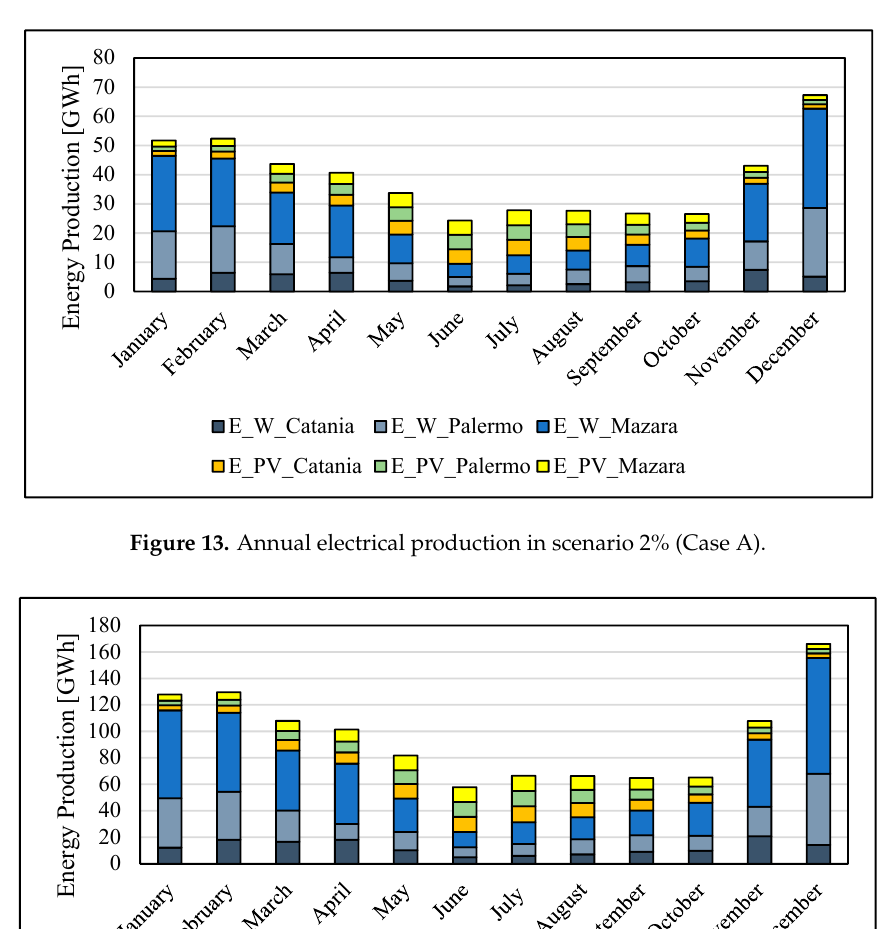
kW Table 4. Monthly solar radiation in the three sites: Catania, Palermo, and Mazara del Vallo [51]. (kWh/m 2 )